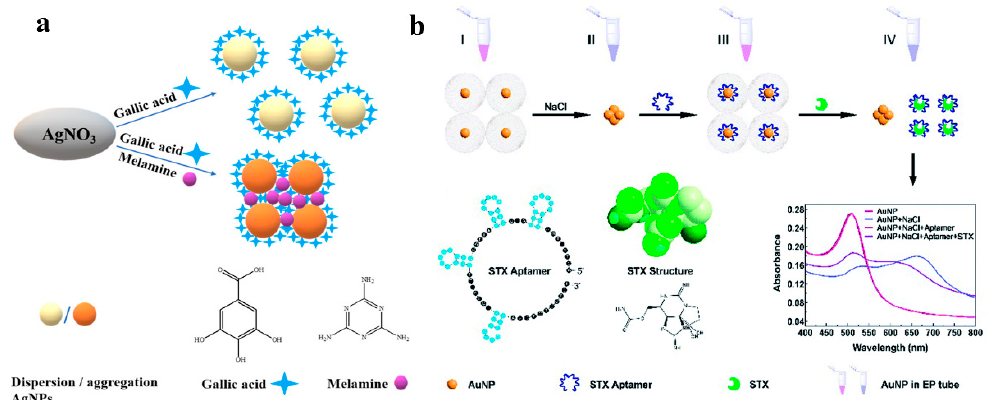
Figure 4. ( a ) Mechanism assay for melamine detection by Ag NPs@galic acid system. Reprinted with permission from Ref. [57]. Copyright 2021 ACS; ( b ) The detection scheme of aptamer-Au NPs for